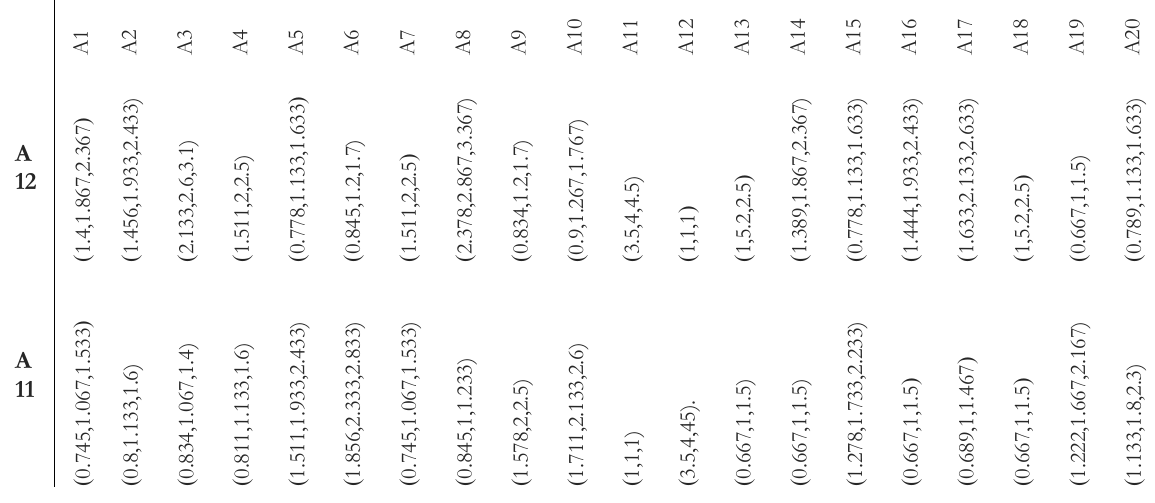
Table 6. Pairwise comparison of executive